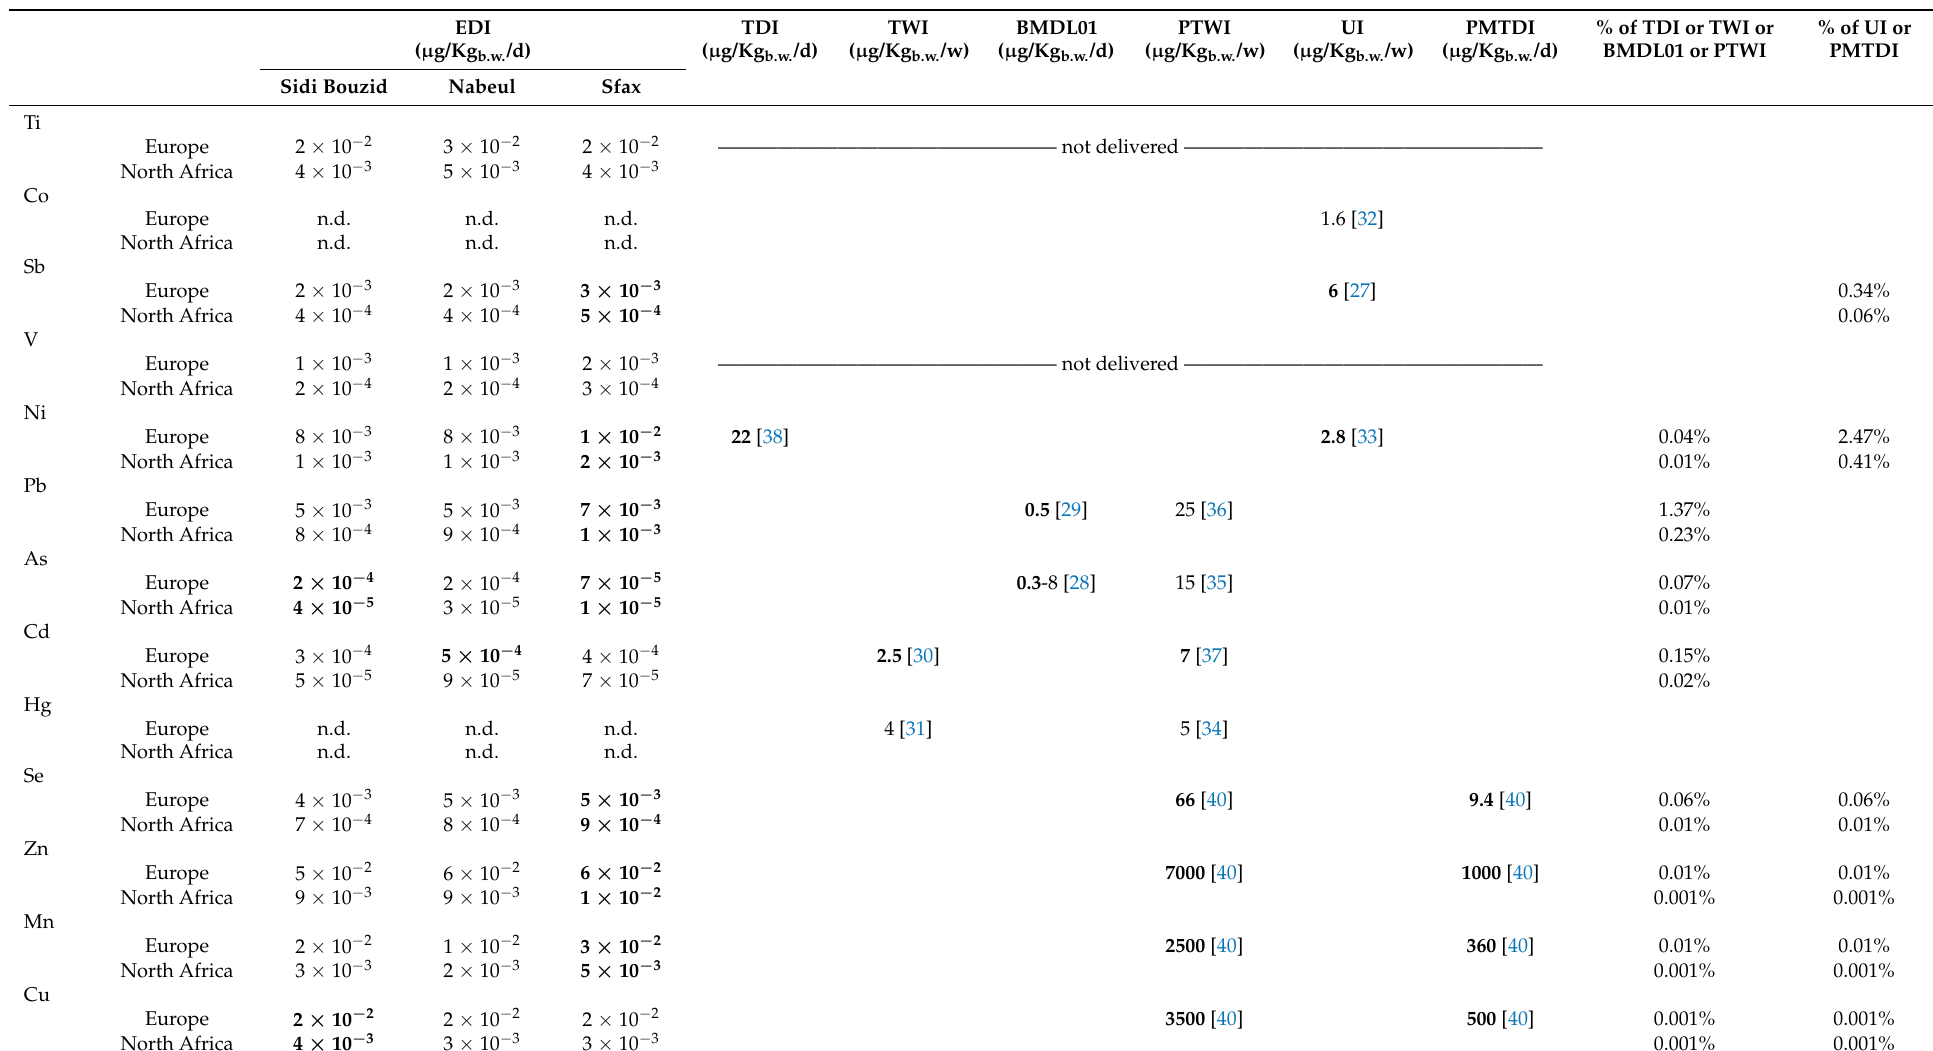
Table 5. Shares of international safety reference values for trace elements by consumption of honey from the three districts of